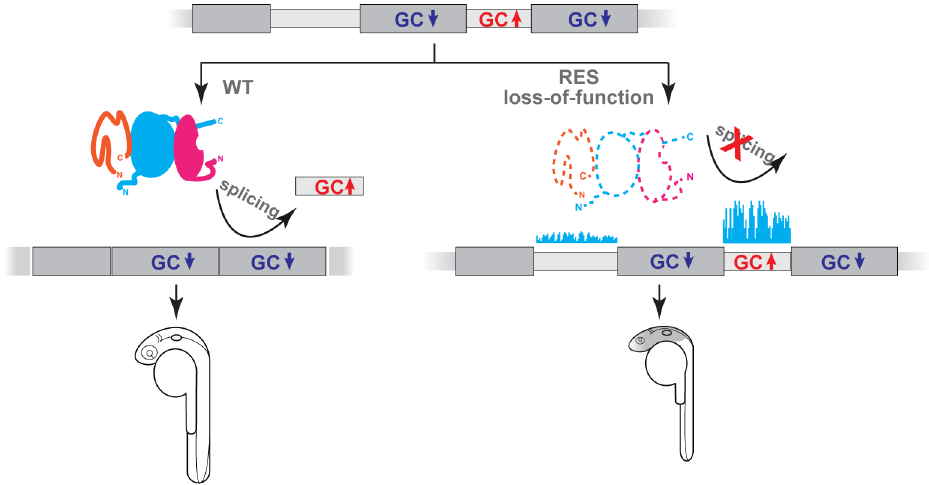
introns are short, have a higher GC content and flanked by GC-depleted exons, features associated with intron definition splicing mechanism. This splicing defect leads to a brain-related